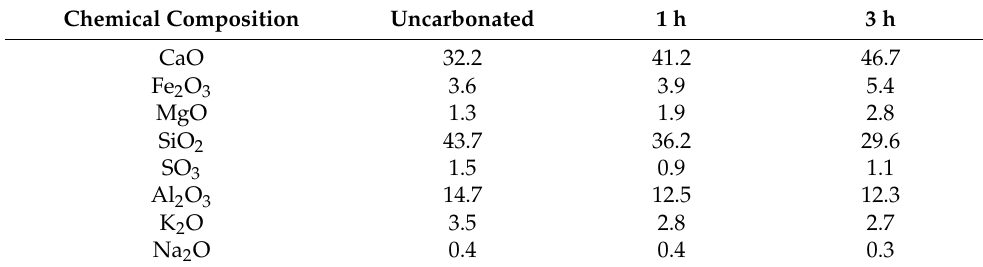
Table 7. Chemical compound (%) after